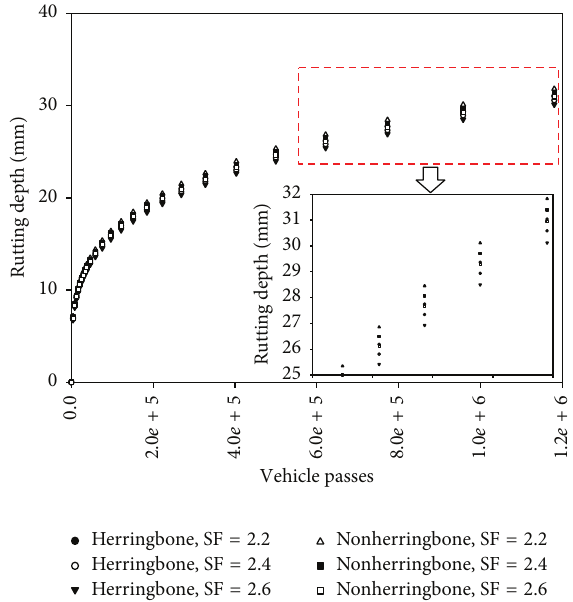
Figure 13: Difference in rut depth depending on block shapes.